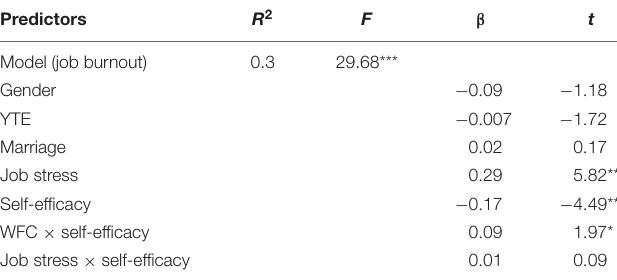
TABLE 3 | Testing the moderated mediation effect of job stress on